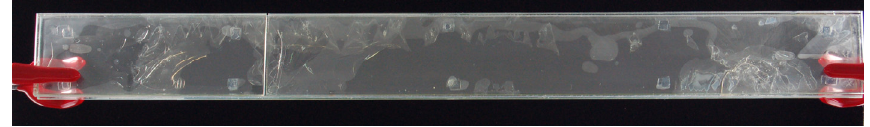
Figure 10: Specimen after climate test according to [7].